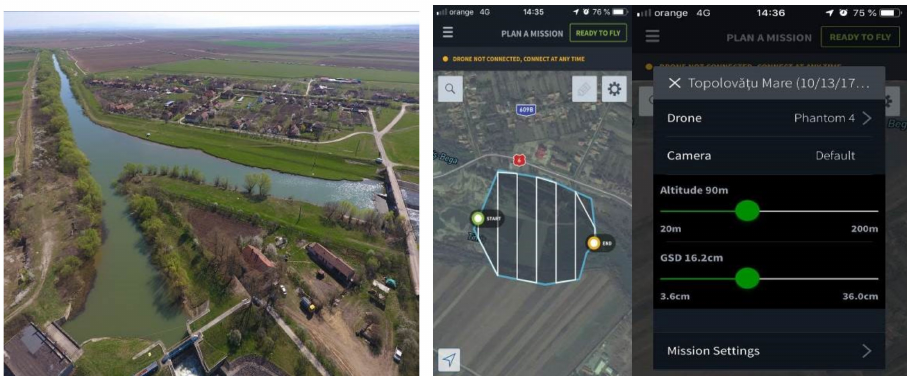
Figure 2. Planning the flight in the study area, with the indication of the flight bands followed by the